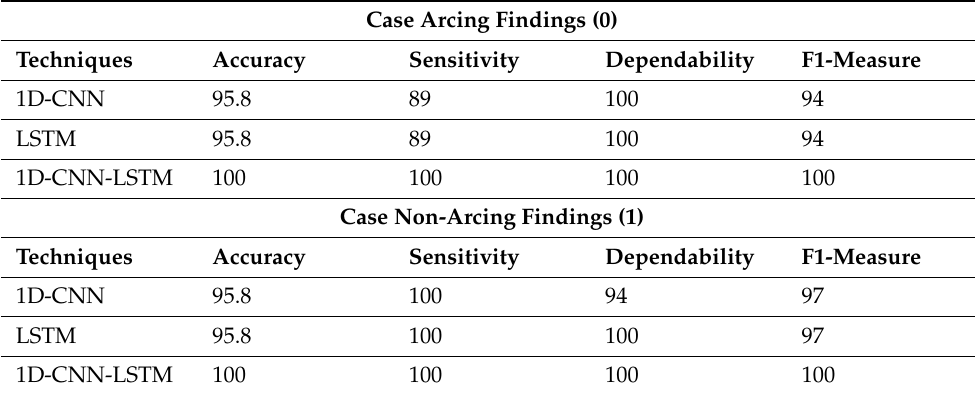
Table 12. The assessment of metrics in accordance with the performance outcomes of DL Structure during testing for the frequency domain in cases of arcing and